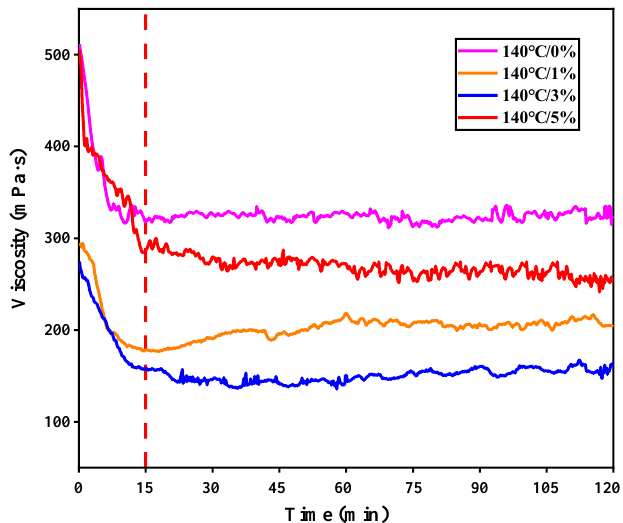
Figure 4. Viscosity variation of the foamed asphalt with time.